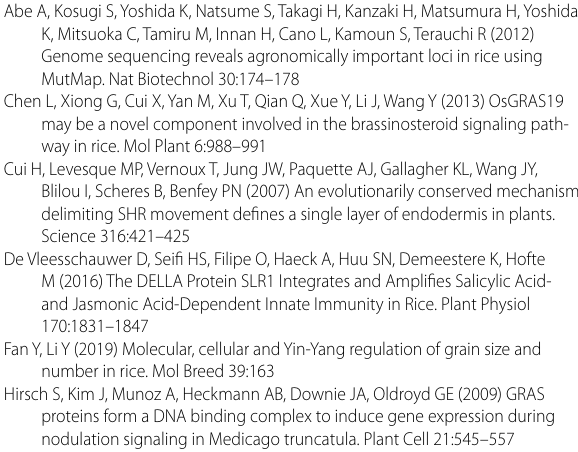
Additional file 1:Figure S1. Comparison of the expression levels of cell-cycle related genes in young panicles of R498 and wg3 by qRT–PCR. Figure S2. Identification of the causal gene responsible for wide